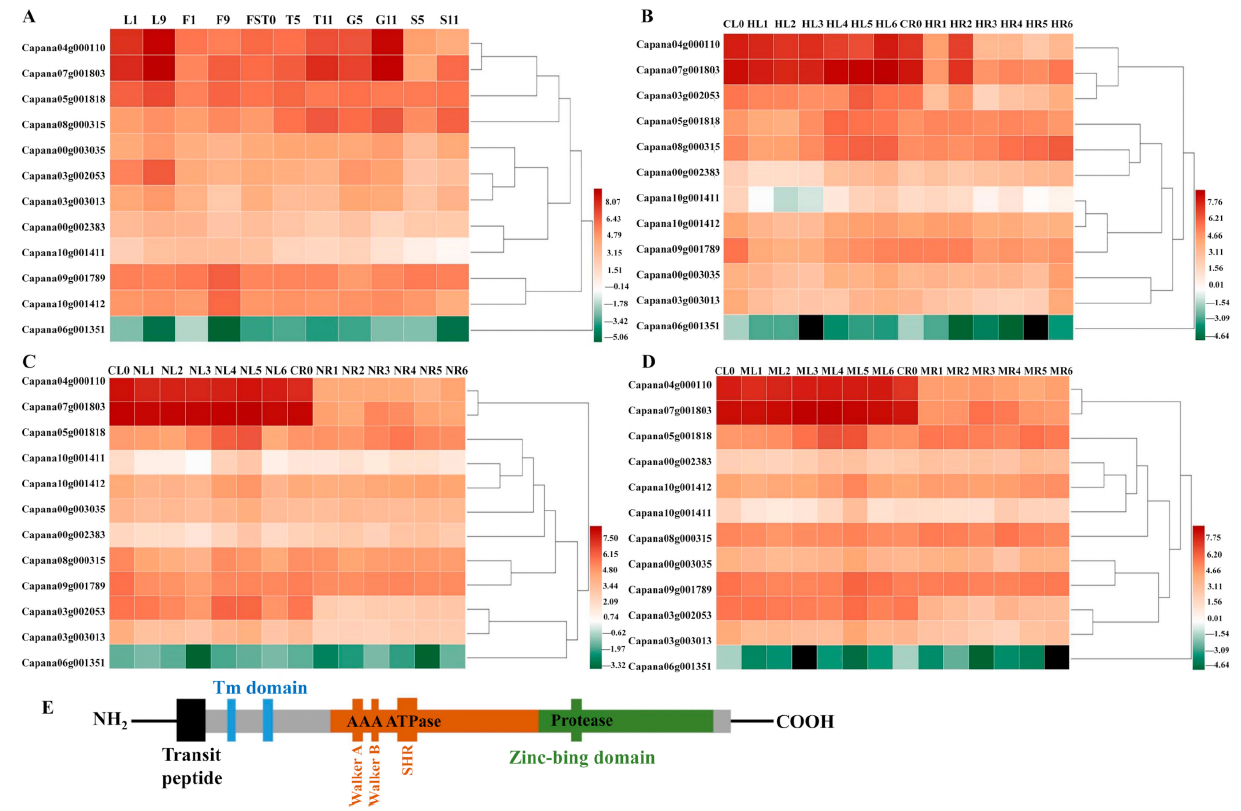
Figure 1. Heat map of CaFtsHs family gene expression in pepper. ( A ) Dynamic heat map of the CaFtsHs family genes in different tissues and organs of pepper. L1 and L9 stand for leaves collected at 2 d and 60 d after emergence, respectively; F1 and F9 describe the smallest and largest flower buds, respectively; FST0 indicates the fruit collected at 3 days after flowering (DAF); T5 and T11 stand for placenta collected at 30 and 60 (DAF), respectively; S5 and S11 show seeds collected at 30 and 60 DAF, respectively; G5 and G11 represent peels collected at 30 and 60 DAF, respectively. ( B ) Expression pattern of CaFtsHs family genes in pepper under heat stress. CL0/CR0 stand for control in leaves/roots, respectively, and HL/HR stand for expression levels of CaFtsHs genes after heat stress (42 ◦ C) in leaves/roots at 0, 0.5, 1, 3, 6, 12, and 24 h t, respectively. ( C ) Expression of CaFtsHs family genes in pepper under salt stress (200 mM NaCl). CL0/CR0 represent control in leaves/roots, respectively; NL/NR stand for levels of CaFtsHs genes in leaves/roots at 0, 0.5, 1, 3, 6, 12, and 24 h post-treatment, respectively. ( D ) Profile of CaFtsHs family genes in pepper leaf and root tissues under osmotic stress (400 mM mannitol).